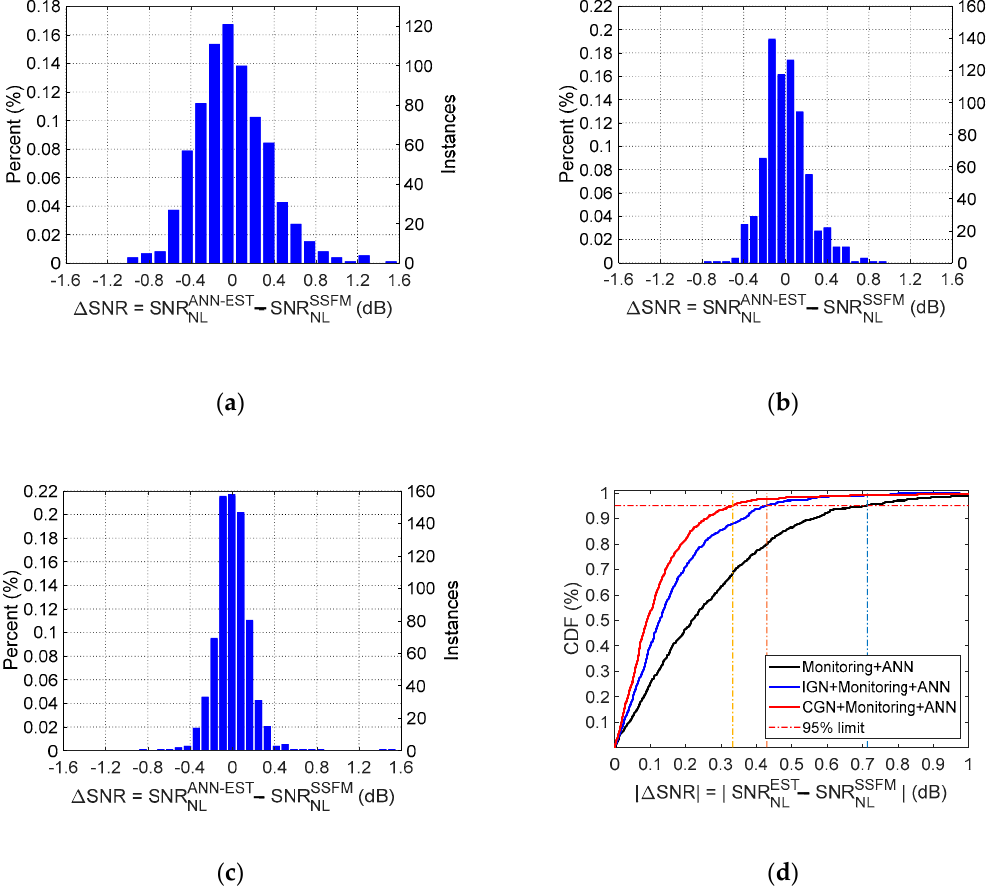
Figure 3. The estimation performance of the monitoring scheme proposed in [5]. ( a ) The error histogram of monitoring performance without any analytical model input. ( b ) The error histogram of monitoring performance with the incoherent Gaussian noise model (IGN). ( c ) The error histogram of monitoring performance with the coherent GN model (CGN). ( d ) The CDF of three monitoring strategies proposed in [5]. SNR ANN − EST and SNR EST means the nonlinear signal-to-noise ratio (SNR) estimated by methods proposed in [5]. SNR SSFM means the nonlinear SNR estimated by the SSFM. ∆ SNR means the estimation di ff erence between the proposed method and the SSFM.